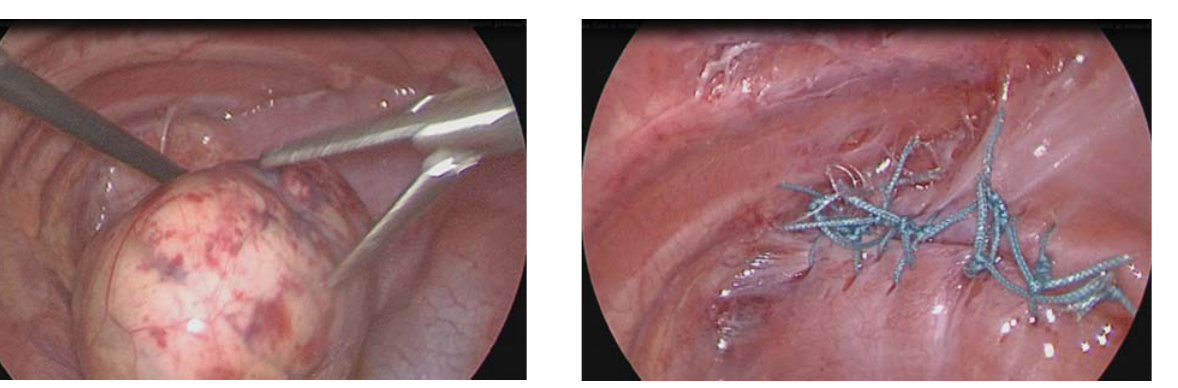
Fig. 4 Primary closure of diaphragmatic